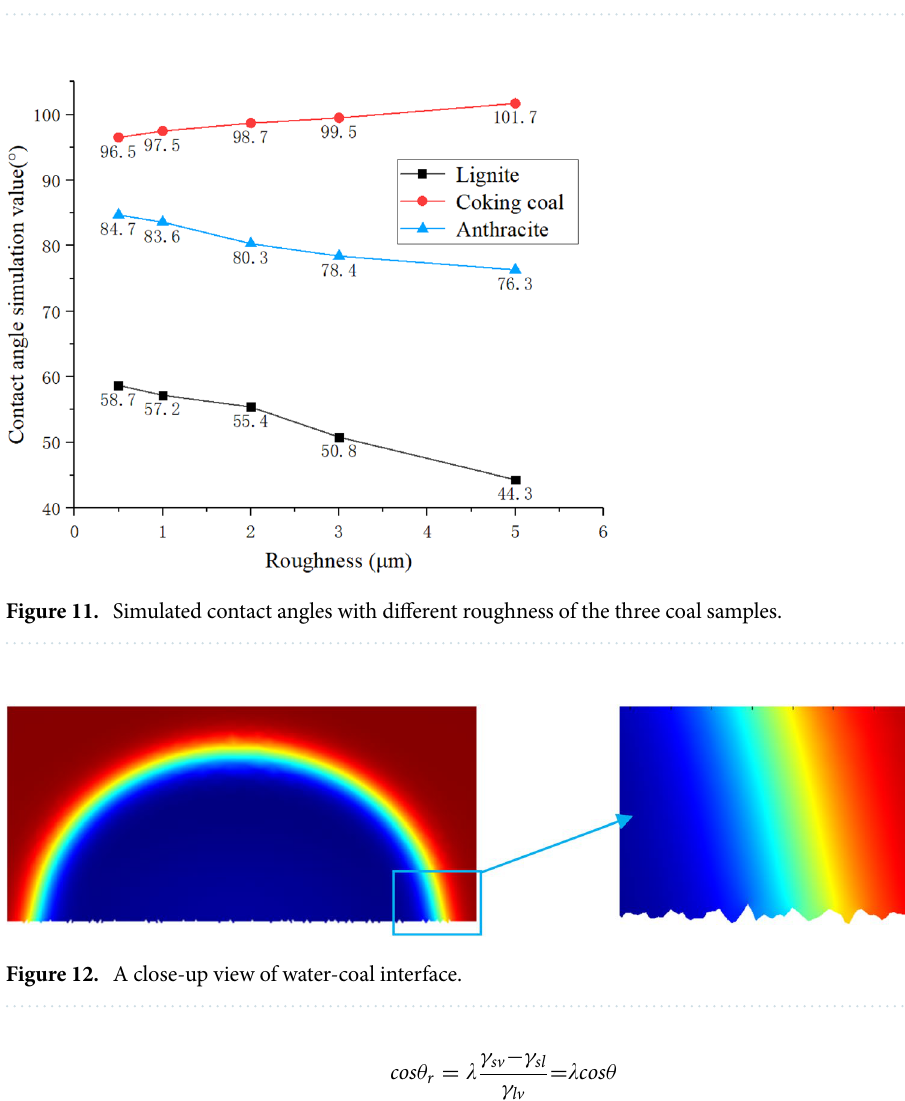
Table 2. Comparison of experimental and simulated contact angles.